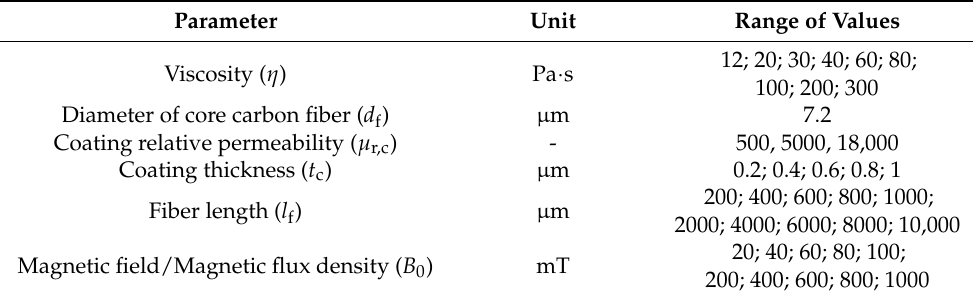
Table 3. Parameter data for the